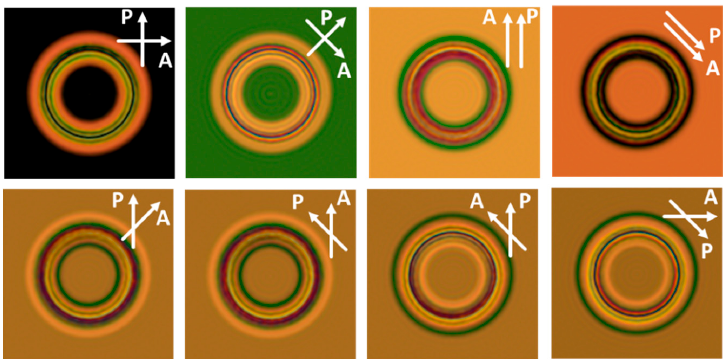
Figure 8. Simulated microscopy images for a 80 µm × 80 µm × 5.5 µm unit cell with dimensions of the patterned rings at the top and bottom substrate r out = 30 µm (r in = 0.4 * r out ). The centra of the patterned rings at the top and bottom substrate overlap (configuration 1). The results are shown for different orientation of the polarizers.